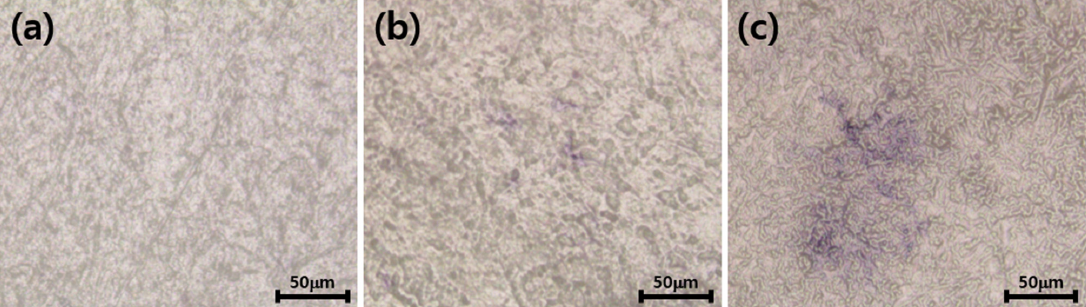
Figure 10. Alkaline phosphatase activity of MC3T3-E1 cells cultured on ZrO 2 ( a ), ZrO 2 -HA ( b ) and ZrO 2 -HA-Col ( c ). After culturing the cells for 14 days, the cells were stained with Fast Blue RR salt and naphthol AS MX phosphate alkaline solution, and a purple image showing ALP activity was observed under an optical microscope.